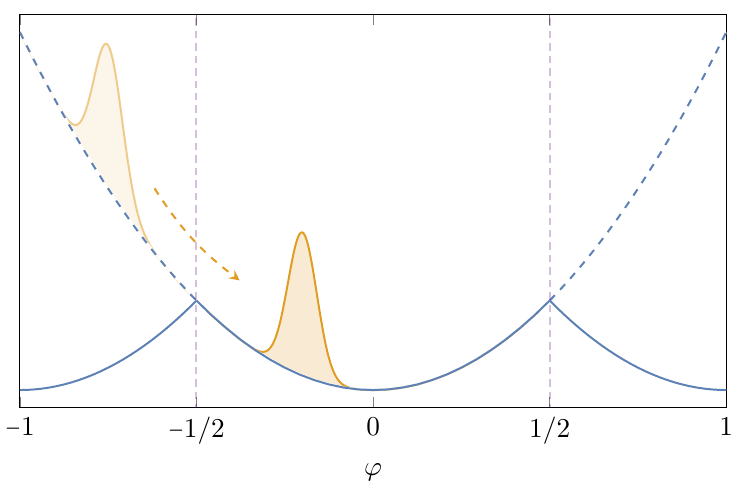
Figure 9. The mixings F n;n 0 and V n;n 0 force the axion onto another branch as it passes across the edge of its fundamental domain. As made obvious in the axion frame, these couplings conspire so that the axion may execute harmonic motion of arbitrary